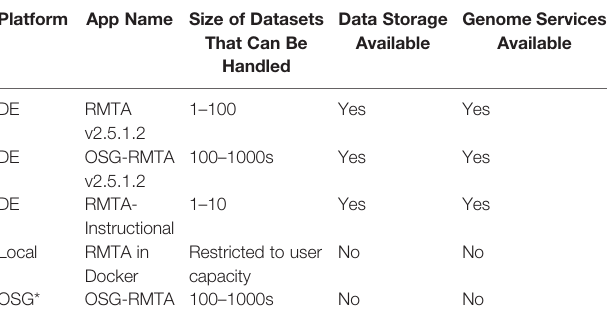
TABLE 1 | Deployment options for read mapping and transcript assembly (RMTA). Platform App Name Size of Datasets That Can Be Handled